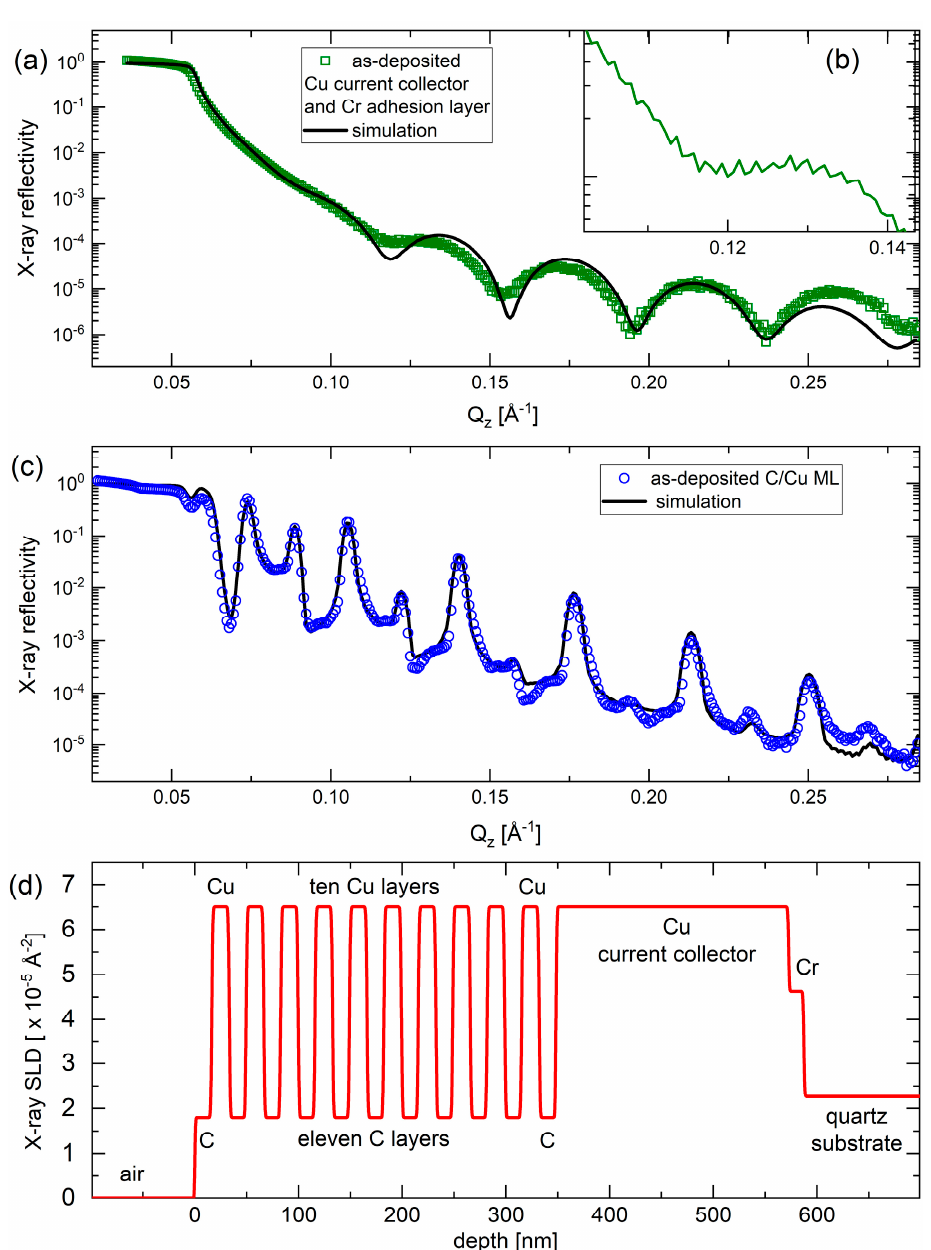
Figure 2. ( a , b ) XRR pattern (green squares in ( a ) and green curve in ( b ) (inset)) and XRR-simulation result (black line in ( a )) on the blank electrode (without the C/Cu ML). Panel ( b ) is a cutout of the XRR data for a better visualization of the tiny oscillation due to the 230 nm thick copper current collector. ( c ) XRR pattern (blue circles) and XRR-simulation result (black line) on the C/Cu ML electrode before mounting the electrode into the electrochemical cell. The X-ray reflectivity represents the fraction between the intensities of the reflected and primary X-ray beams. ( d ) Depth profile of the X-ray scattering length density of the XRR-simulation result presented in ( c ). The measurement results were collected on a Panalytical Empyrean diffractometer. A color version of this figure can be viewed online.